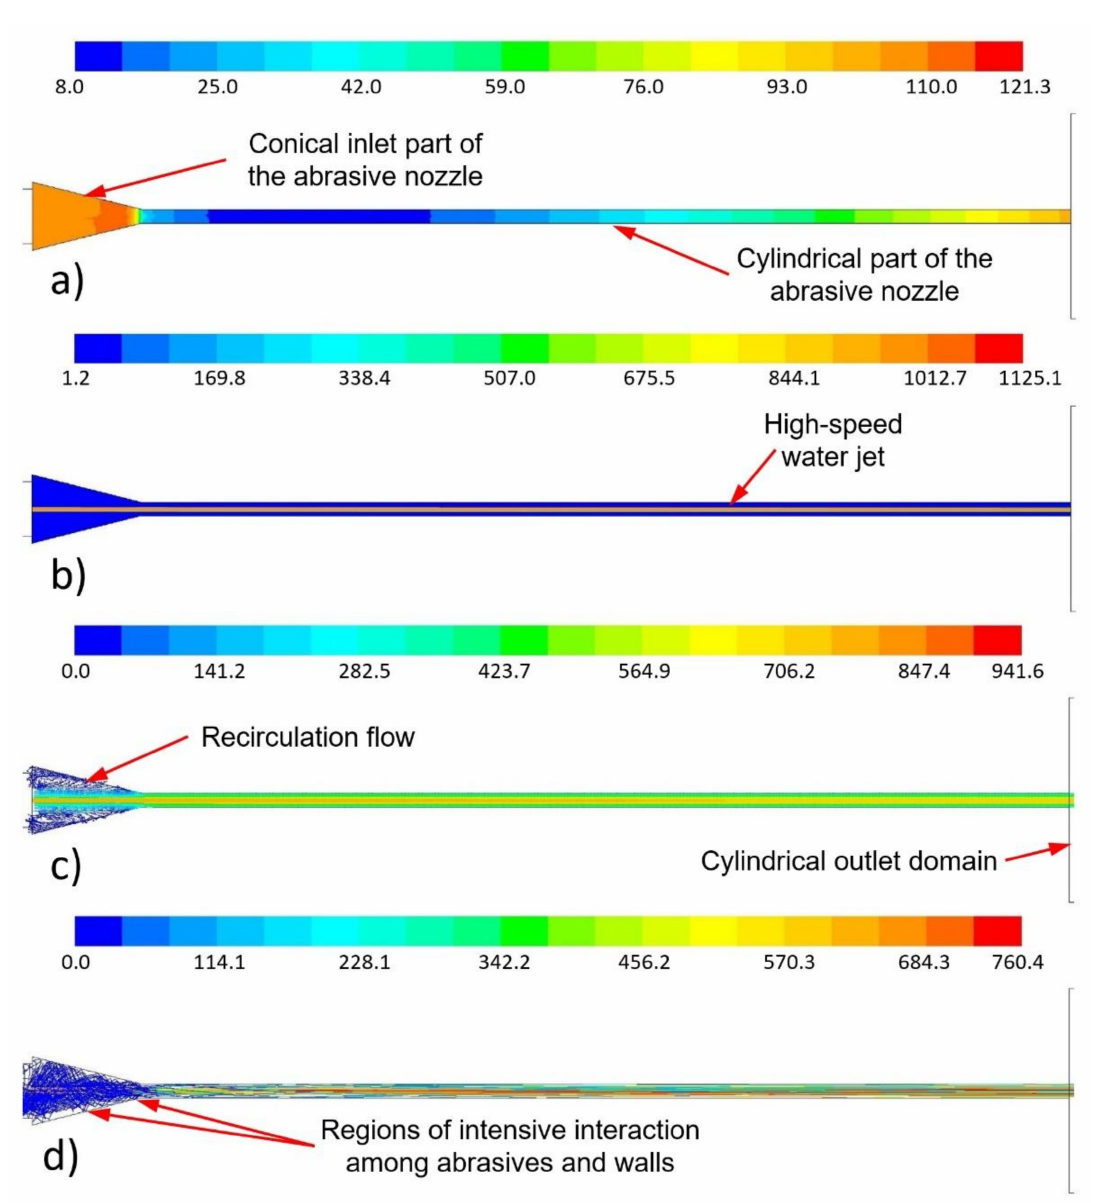
Figure 11. Calculated flow field in the abrasive nozzle under the feeding pressure of 406 MPa: ( a ) distribution of the pressure (kPa (abs)); ( b ) distribution of the density (kg/m 3 ); ( c ) distribution of the velocity vector (m/s); ( d ) abrasive particle traces coloured by particle velocity magnitude (m/s)—abrasive particle mass flow rate of 100